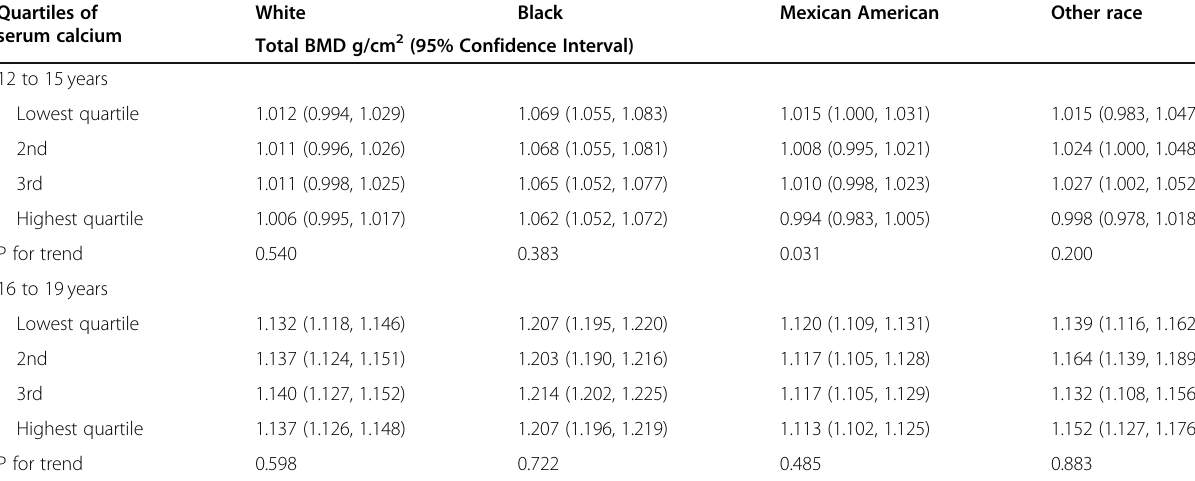
Table 3 Total bone mineral density by quartiles of serum calcium, stratified by race/ethnicity and age Quartiles of serum